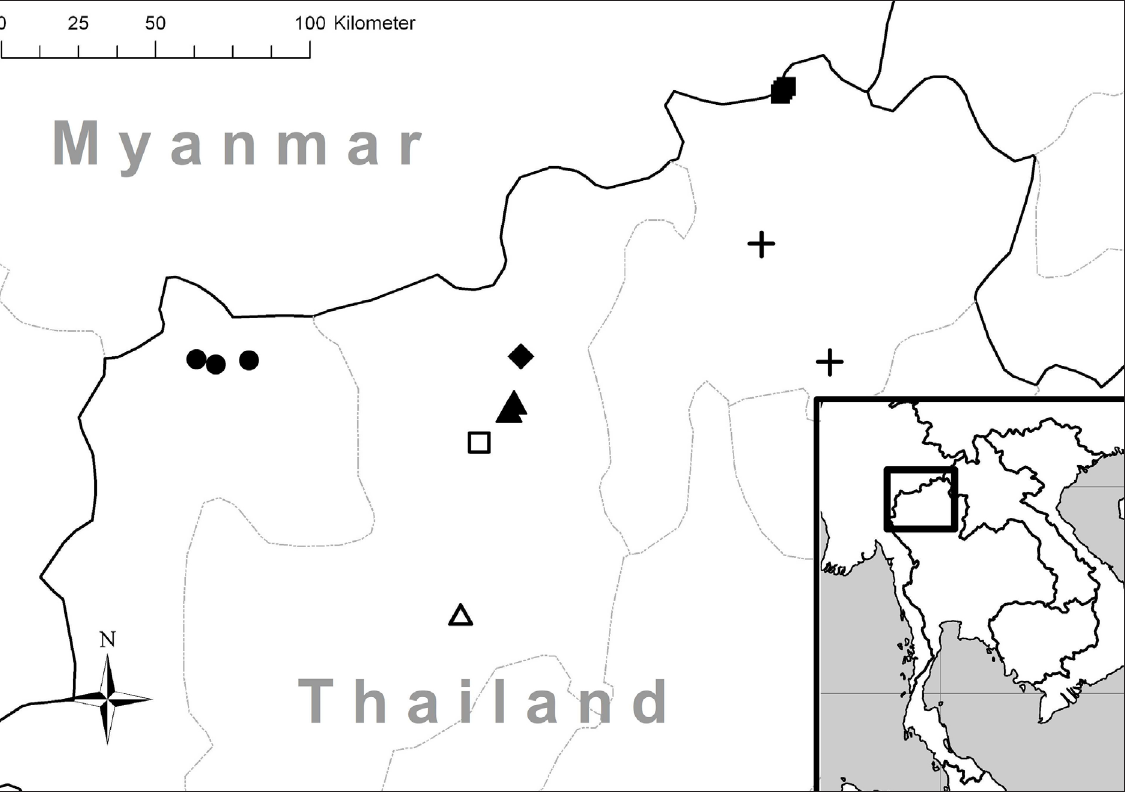
Fig. 17. Distribution of plectopylid species in Northern Thailand. Legends: circle = Chersaecia auffenbergi sp. nov.; triangle = Chersaecia leiophis (Benson, 1860) (empty triangle shows the type locality of Plectopylis degerbolae Solem, 1966); empty square = Chersaecia perarcta simplex (Solem, 1966); cross = Chersaecia perarcta perarcta (Blanford, 1865); filled square = Chersaecia scabra sp. nov.; rhomb = Chersaecia densegyrata sp. nov.; the upper filled triangle also shows the locality of Naggsia oligogyra sp.